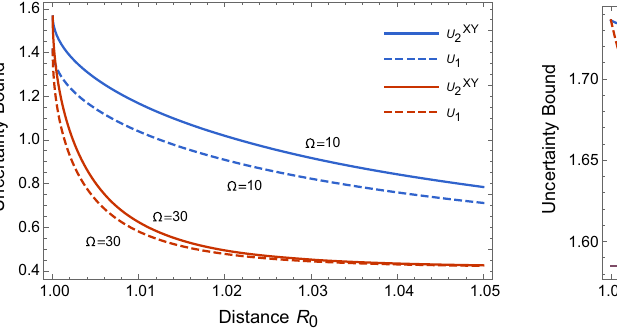
Fig. 4 The left figure depicts the uncertainty bound U 1 and U xy with respect to R 0 = r 0 / 2 M when Ω = ω/ T H = 10 , 30. The right figure shows the gap between left side and right side: Δ 1 = H ( X | R ) + H ( Y | R ) − U 1 and Δ xy